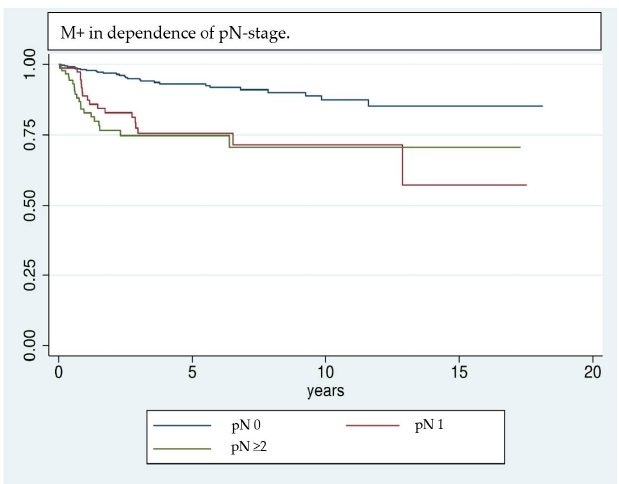
Figure 2. Kaplan–Meier analysis of the development of M+ in dependence of the pN stage. Patients who had lymph node invasion at the time of initial diagnosis are more likely to develop distant metastases in the further course of events.